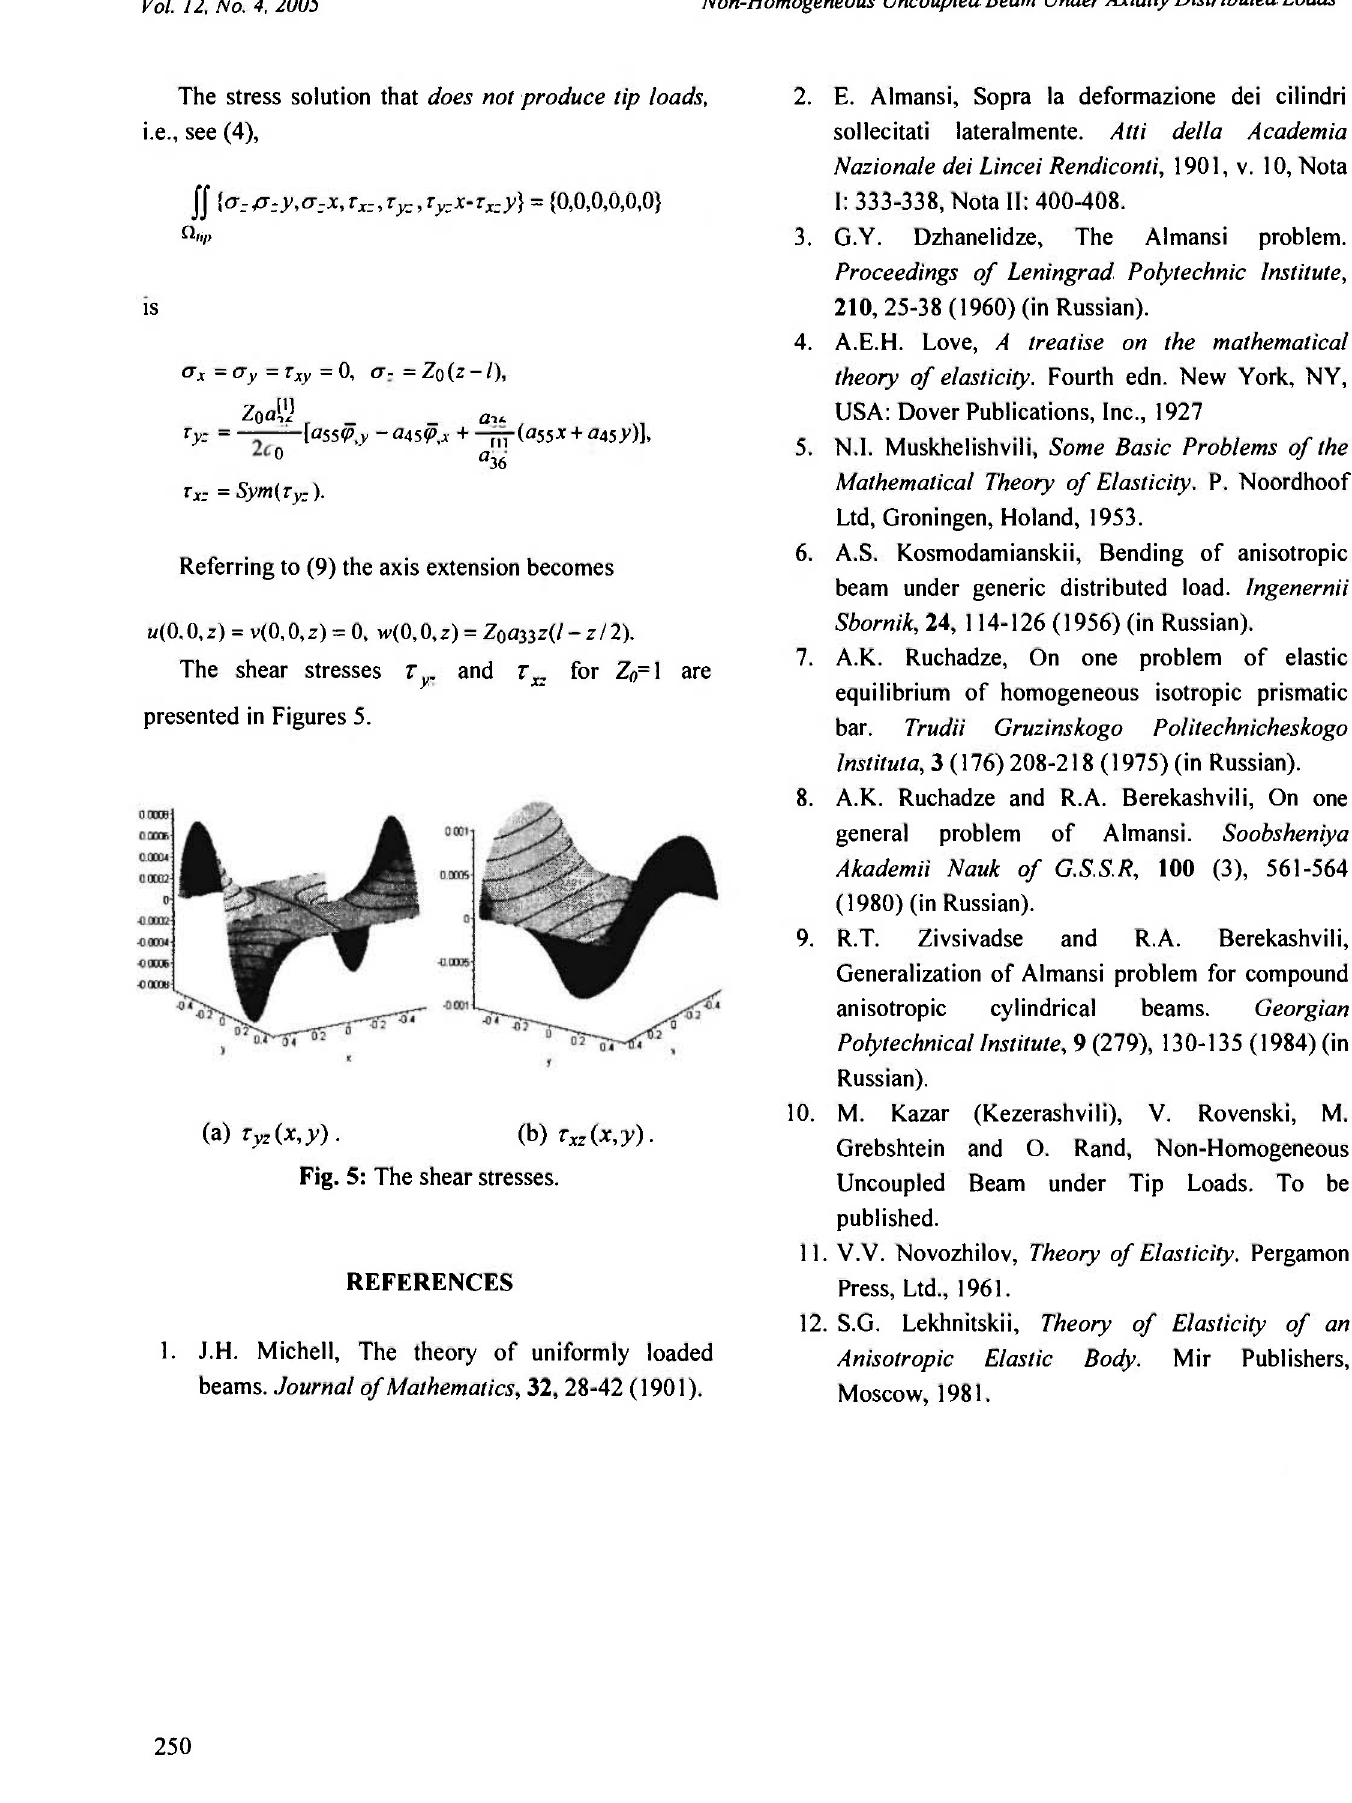
Fig. 5: The shear